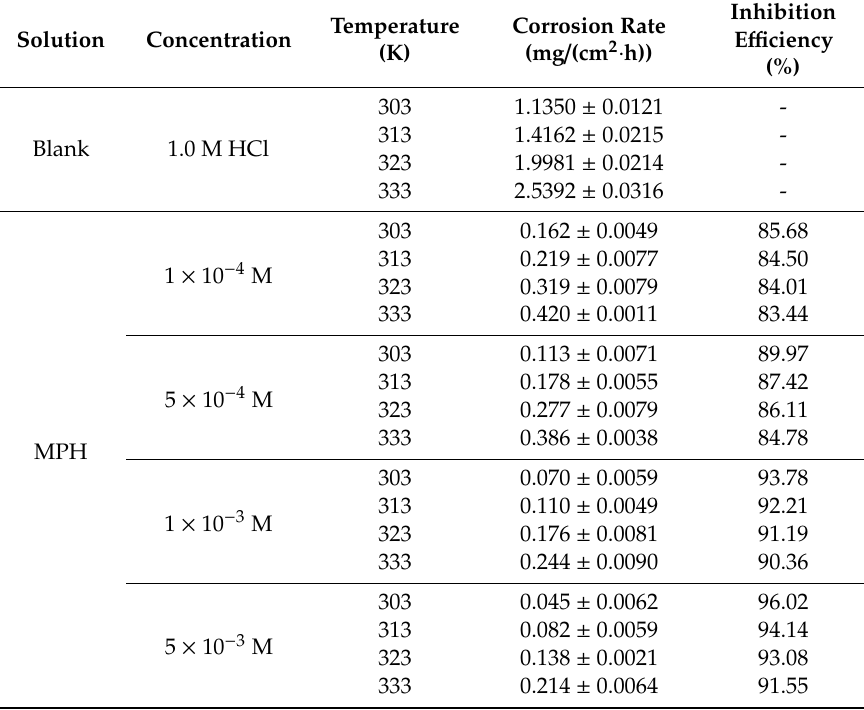
Table 4. The e ff ect of temperature on inhibition e ffi ciency and the corrosion rate of MPH.